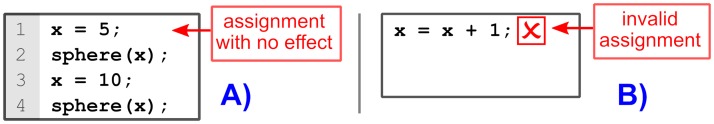
OpenSCAD sample codes to show the effect of its functional programming paradigm.(A) Assignment in line 1 has no effect since variables keep a constant value during their entire lifetime. (B) The code shows an invalid assignment since variables cannot change their values.